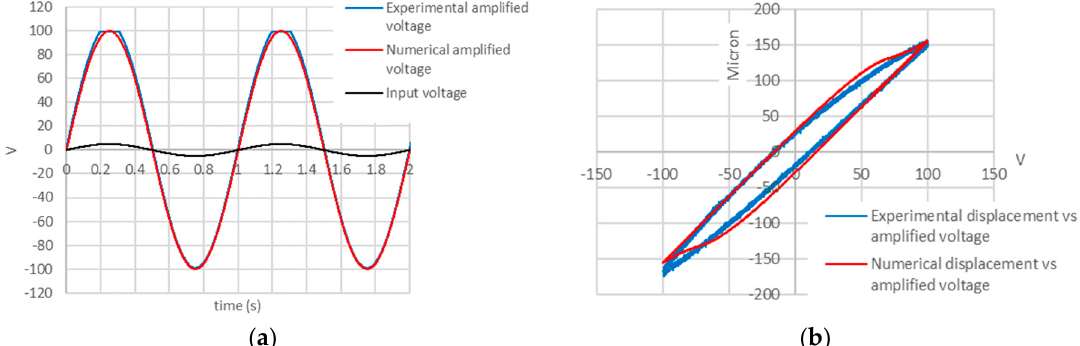
Figure 5. Test 1. Comparison between measured amplified voltage and simulated one for a sine wave control voltage (input voltage to the amplifier) having 5 V amplitude and 1 Hz frequency: ( a ); corresponding plots of the displacement of the ring bender vs. amplified voltage with atmospheric pressure inside the valve: ( b ).